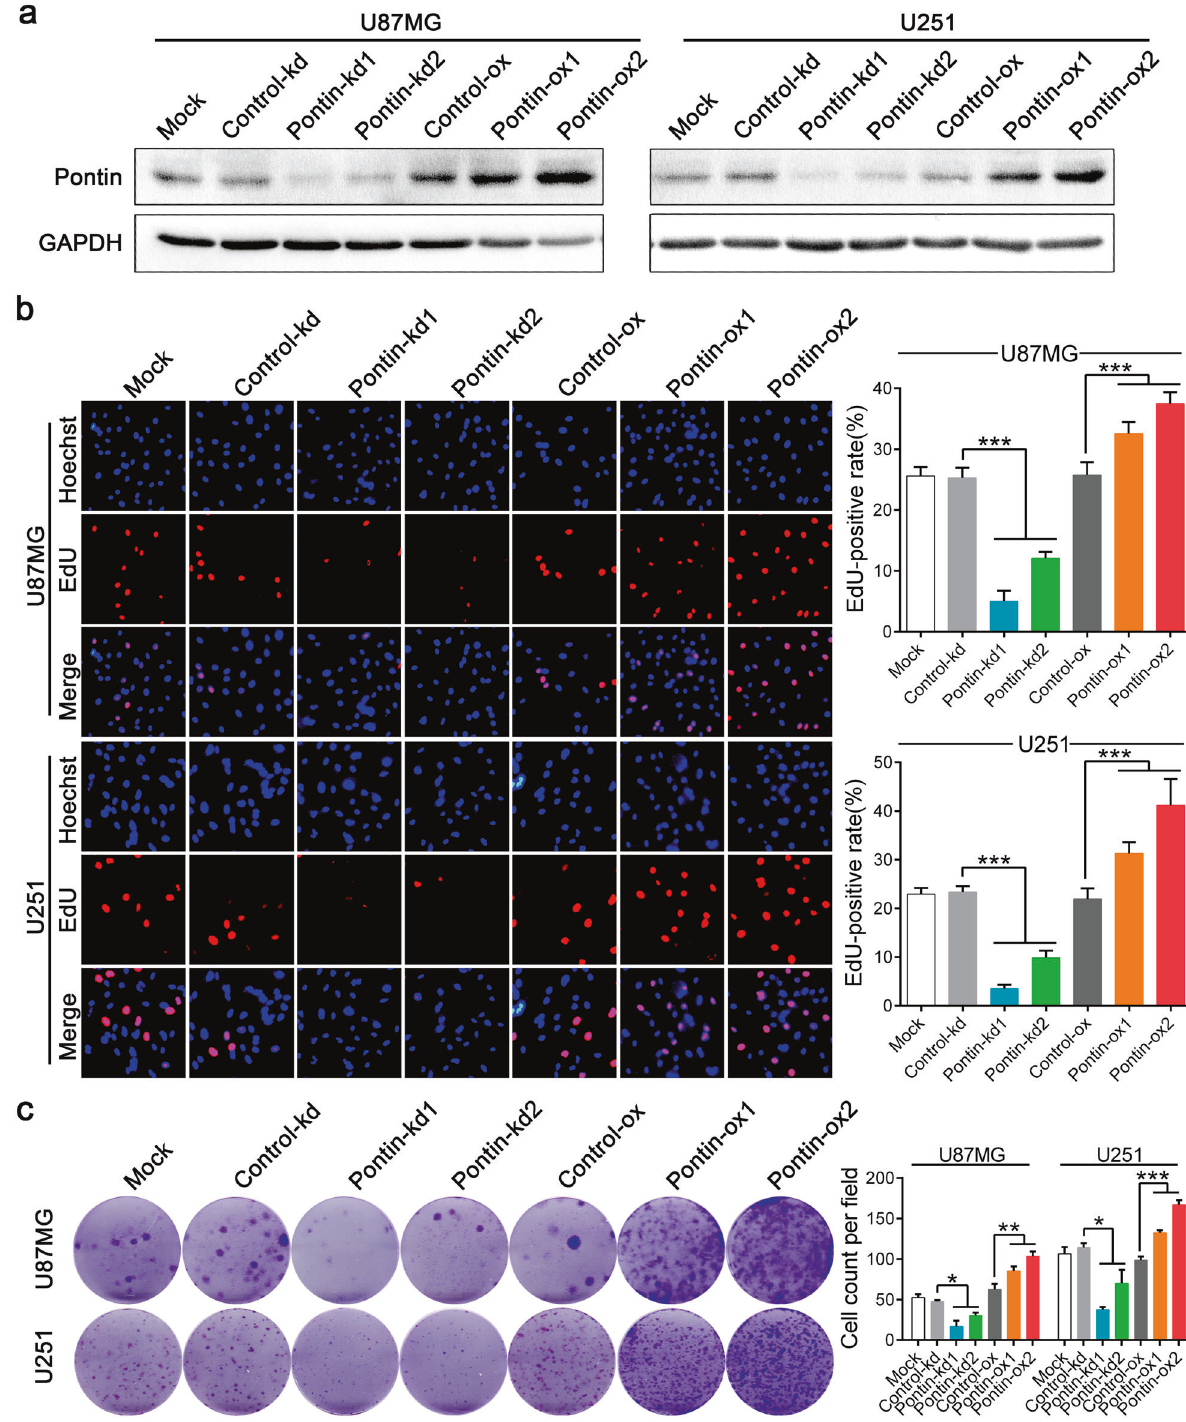
Fig. 2 Pontin facilitates GBM cell proliferation and survival. a Western blot of Pontin in the extracts of the established Pontin-silenced or -overexpressed U87MG and U251 cells. Loading control, GAPDH. b Representative images of EdU staining (left) and the quantitative analysis of EdU-positive rates among the multiple groups (right). c Cell survival results re fl ected by colony formation assay. Data in b, c are expressed as means ± SDs, n = 3. *** P < 0.001 by one-way ANOVA (Dunnett ’ s post